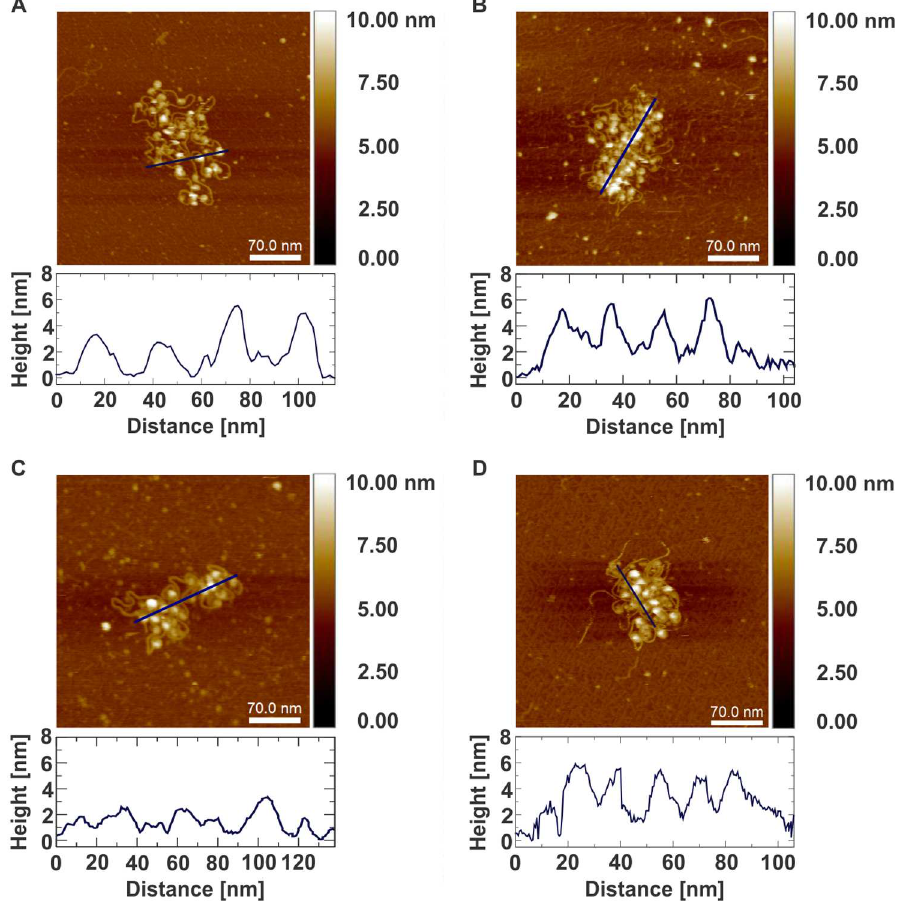
Fig 1. AFM imaging of chromatin arraysunder different salt concentrations. Data showingarrays in A: 0 mM NaCl, B: 30 mM NaCl, C: 75 mM NaCl, D: 250 mM NaCl. Each panel displaysa singlearray together with a height profile of a cross-sectionas indicatedin dark blue. Pictures were chosen to best representthe averagecompactionlevel of the correspondingsodium chlorideconcentration.